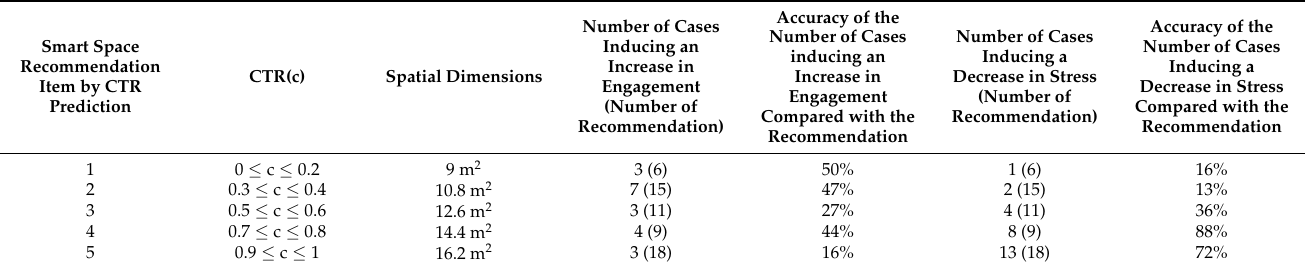
Table 1. Accuracy in number and rate according to increase in engagement and decrease in stress compared to the number of recommendations by AI.